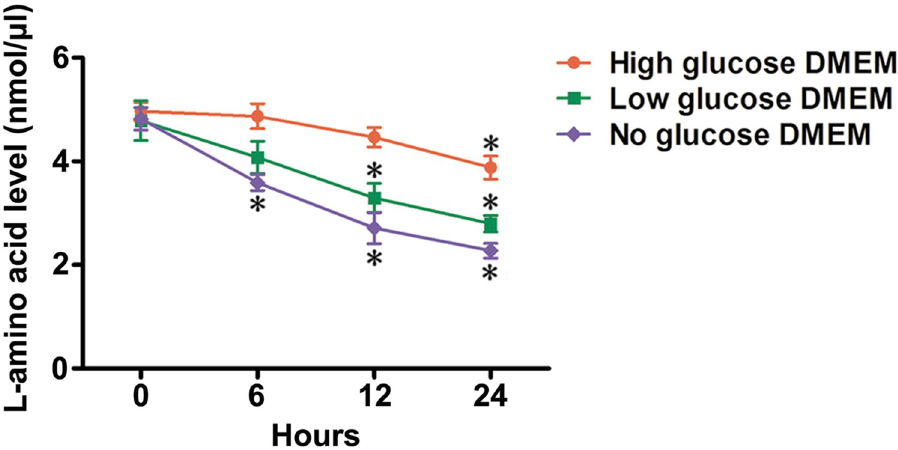
Fig 4. L-amino acid level in cultured supernatant of different DMEM. L-amino acid level in cultured supernatant of high, low, and no glucose DMEM was quantified at 0, 6, 12, and 24 h of feeding. Data were represented as means ± SD. Statistical significance was evaluated by ANOVA. � P < 0.05 versus 0